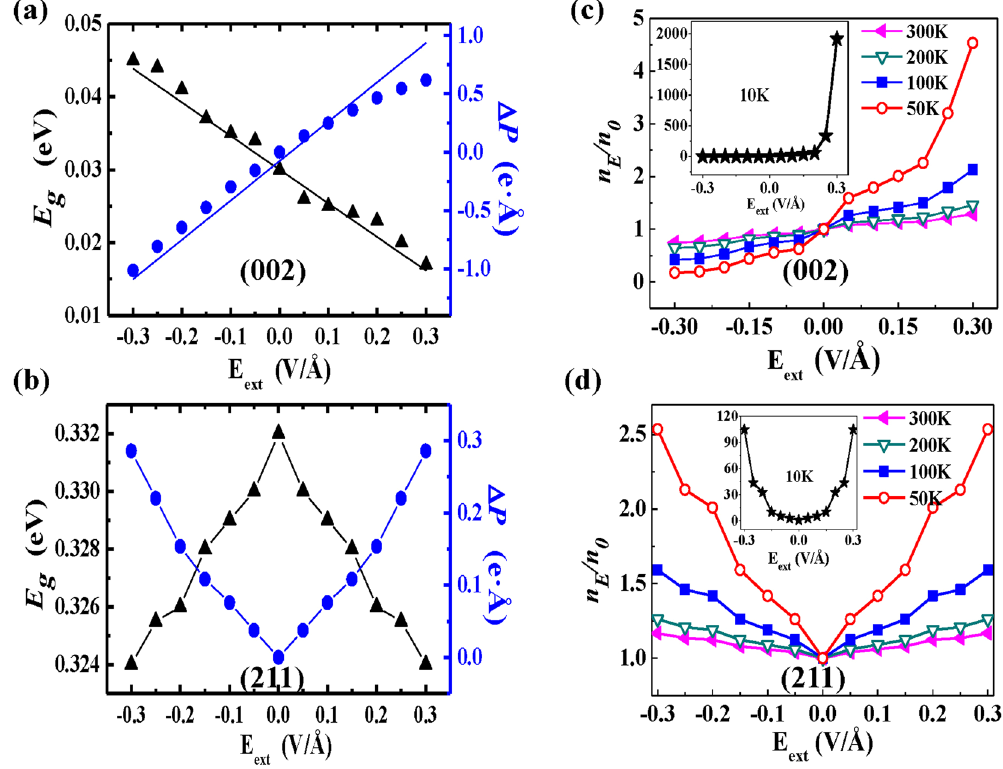
Figure 3. The band gap E g , the dipole shift ( Δ P ) and the intrinsic charge carrier concentration ratio n E / n 0 , and the resistivity ρ as a function of the external electric field E ext for PbPdO 2 : ( a ) and ( c ) for (002) orientation; ( b ) and ( d ) for (211) orientation,